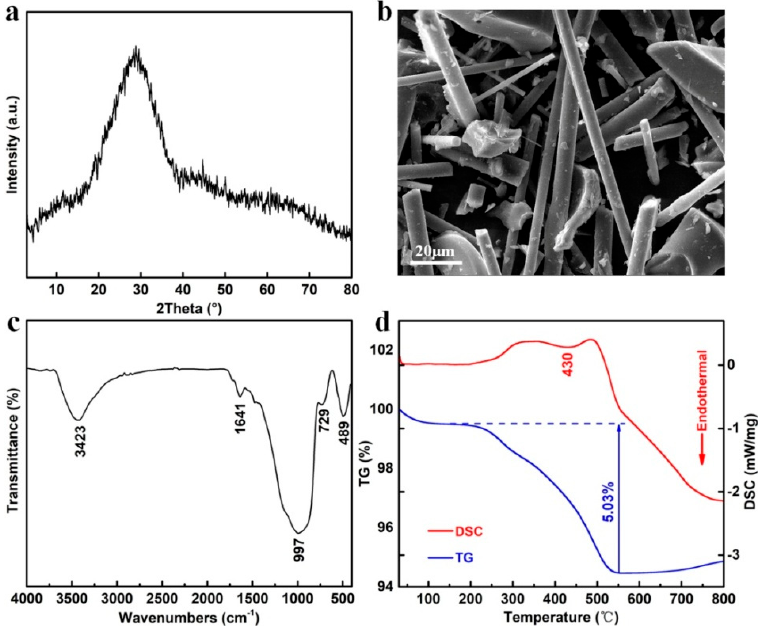
Figure 1. ( a ) XRD pattern, ( b ) SEM image, ( c ) FTIR spectrum, and ( d ) TG and DSC curves of basalt fiber.